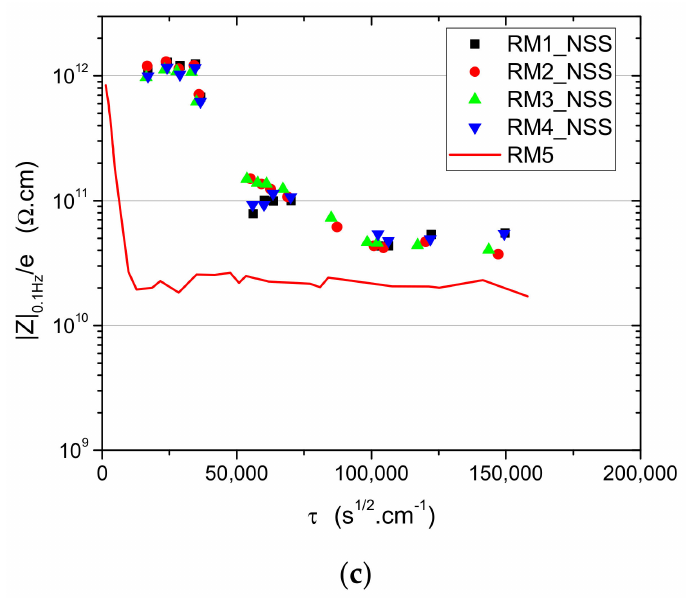
Figure 7. Evolution of | Z | 0.1 Hz /e vs. reduced time for the ageing in cyclic NSS for ( a ) ROX system, ( b ) RG system, and ( c ) RM